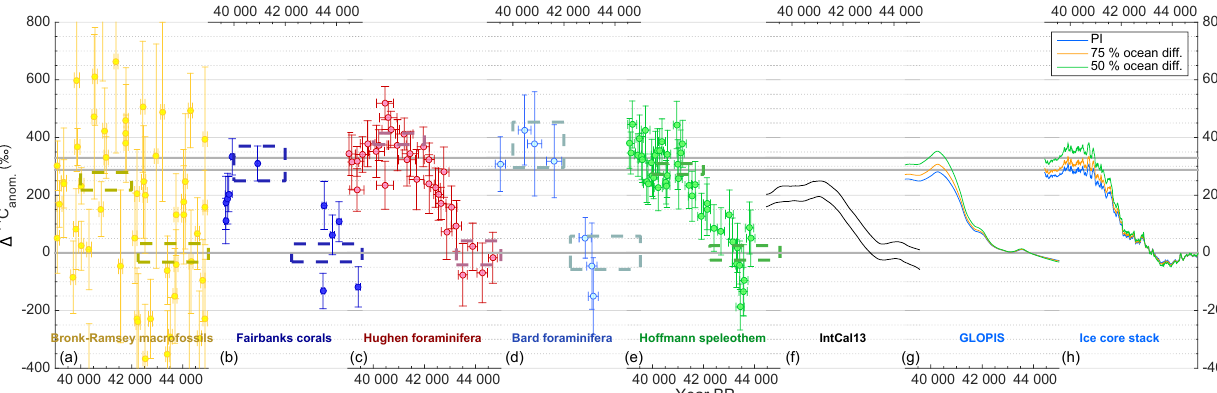
Figure 4. The Laschamp event in measured and modeled (cid:49) 14 C. (a–f) (cid:49) 14 C anomalies in macrofossils from Lake Suigetsu (yellow; Bronk Ramsey et al., 2012), tropical corals (blue; Fairbanks et al., 2005), foraminifera from Cariaco Basin sediments (red; Hughen et al., 2006), foraminifera from Iberian Margin sediments (light blue; Bard et al., 2013), Bahamas speleothems (green; Hoffmann et al., 2010), and IntCal13 (black; Reimer et al., 2013). All data are shown as anomalies to their error-weighted mean prior to the Laschamp event, i.e., the (cid:49) 14 C increase. The dashed boxes encompass the time periods and (cid:49) 14 C uncertainties (error of the error-weighted mean) used for the definition of the pre- and post-Laschamp event levels. (g, h) Modeled (cid:49) 14 C using the GLOPIS (Laj et al., 2004) geomagnetic field record and the ice-core stack as production rate inputs. The different colored lines reflect different carbon cycle scenarios (see legend; PI denotes preindustrial). The conversion of geomagnetic field intensity to 14 C production rate is based on the production rate model by Herbst et al. (2016). Note that the amplitude of the 10 Be variations has been increased by 30% as discussed in Sect.